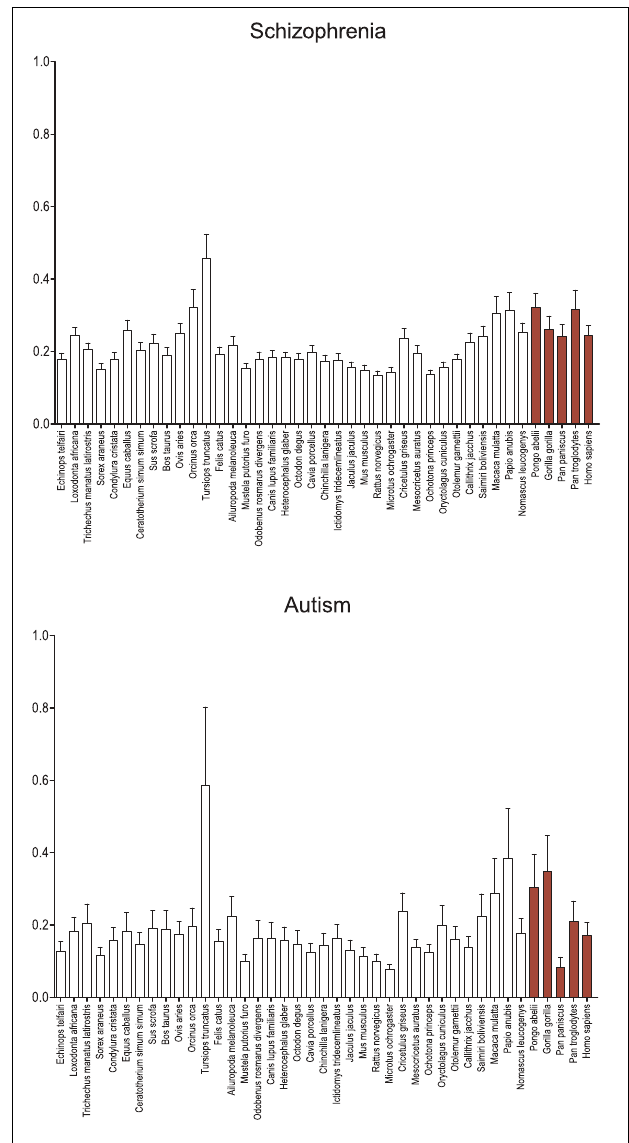
FIGURE 2 | Average d N /d S across taxa of genes associated with schizophrenia and autism. Average d N /d S of genes positively associated with schizophrenia (top) and autism (bottom) based on positive gene-disease associations collated by the Genetic Association Database (GAD) are depicted. Average d N /d S ratios suggest changes in selective regime in catarrhines and dophin in genes associated with these neurodevelopmental diseases. Pairwise significance values are shown in Supplemental Table